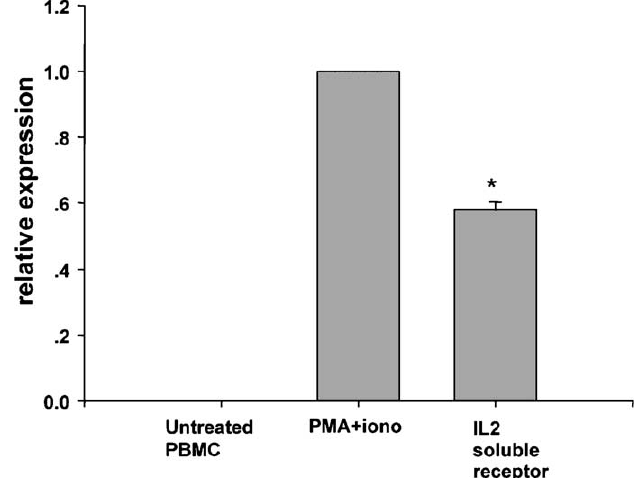
Fig. 4B. The induction of human IL-13Ra2 transcript G in PBMC. Human IL-13Ra2 transcript G can be induced in PBMCs with the stimulation of PMA/Iono, and the induction can be inhibited by soluble IL-2 receptors.